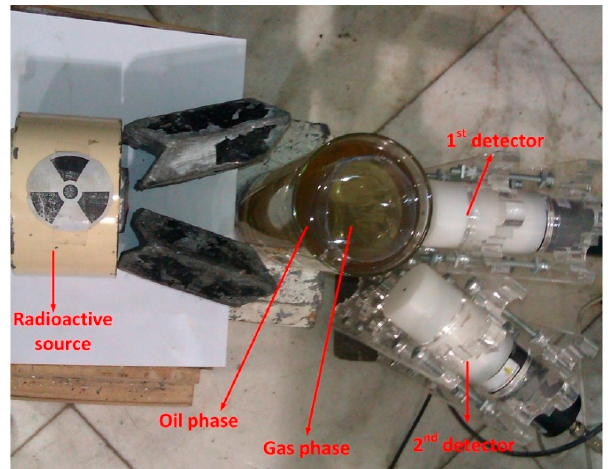
Figure 4. Experimental setup including 2 NaI detectors and one radioactive source [28].